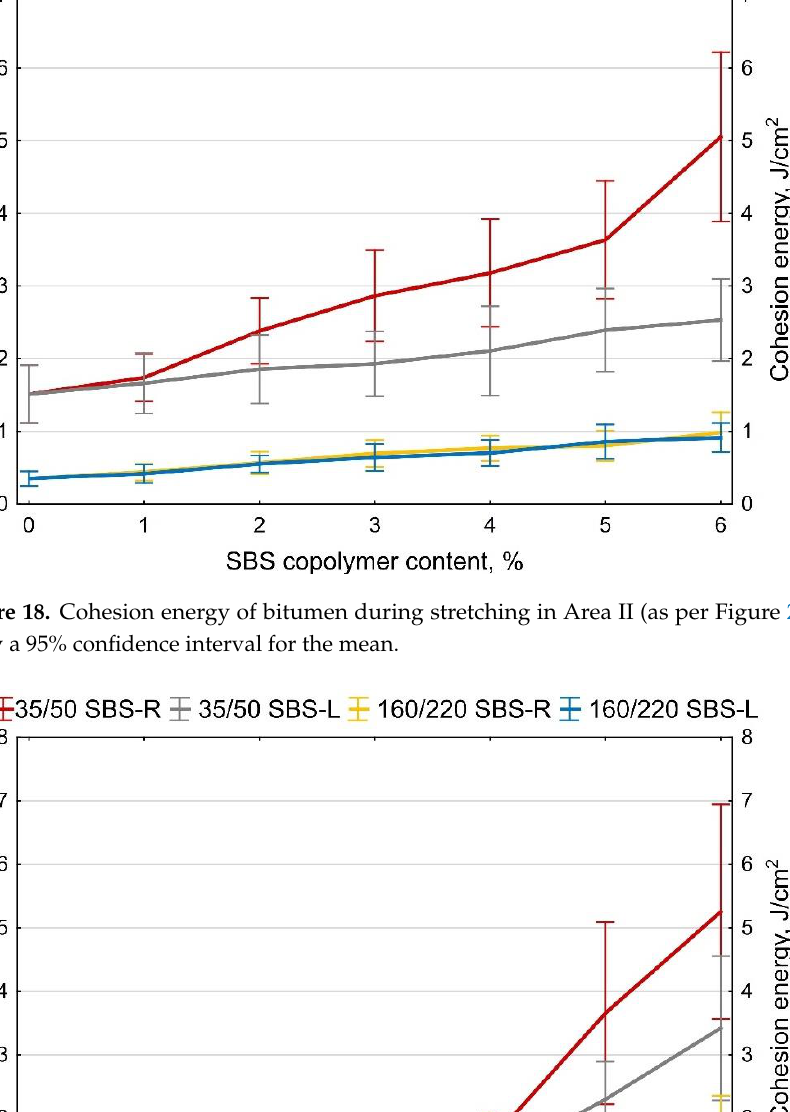
Figure 17. Cohesion energy of bitumen during stretching in Area I (as per Figure 2b), error bars show a 95% confidence interval for the mean.